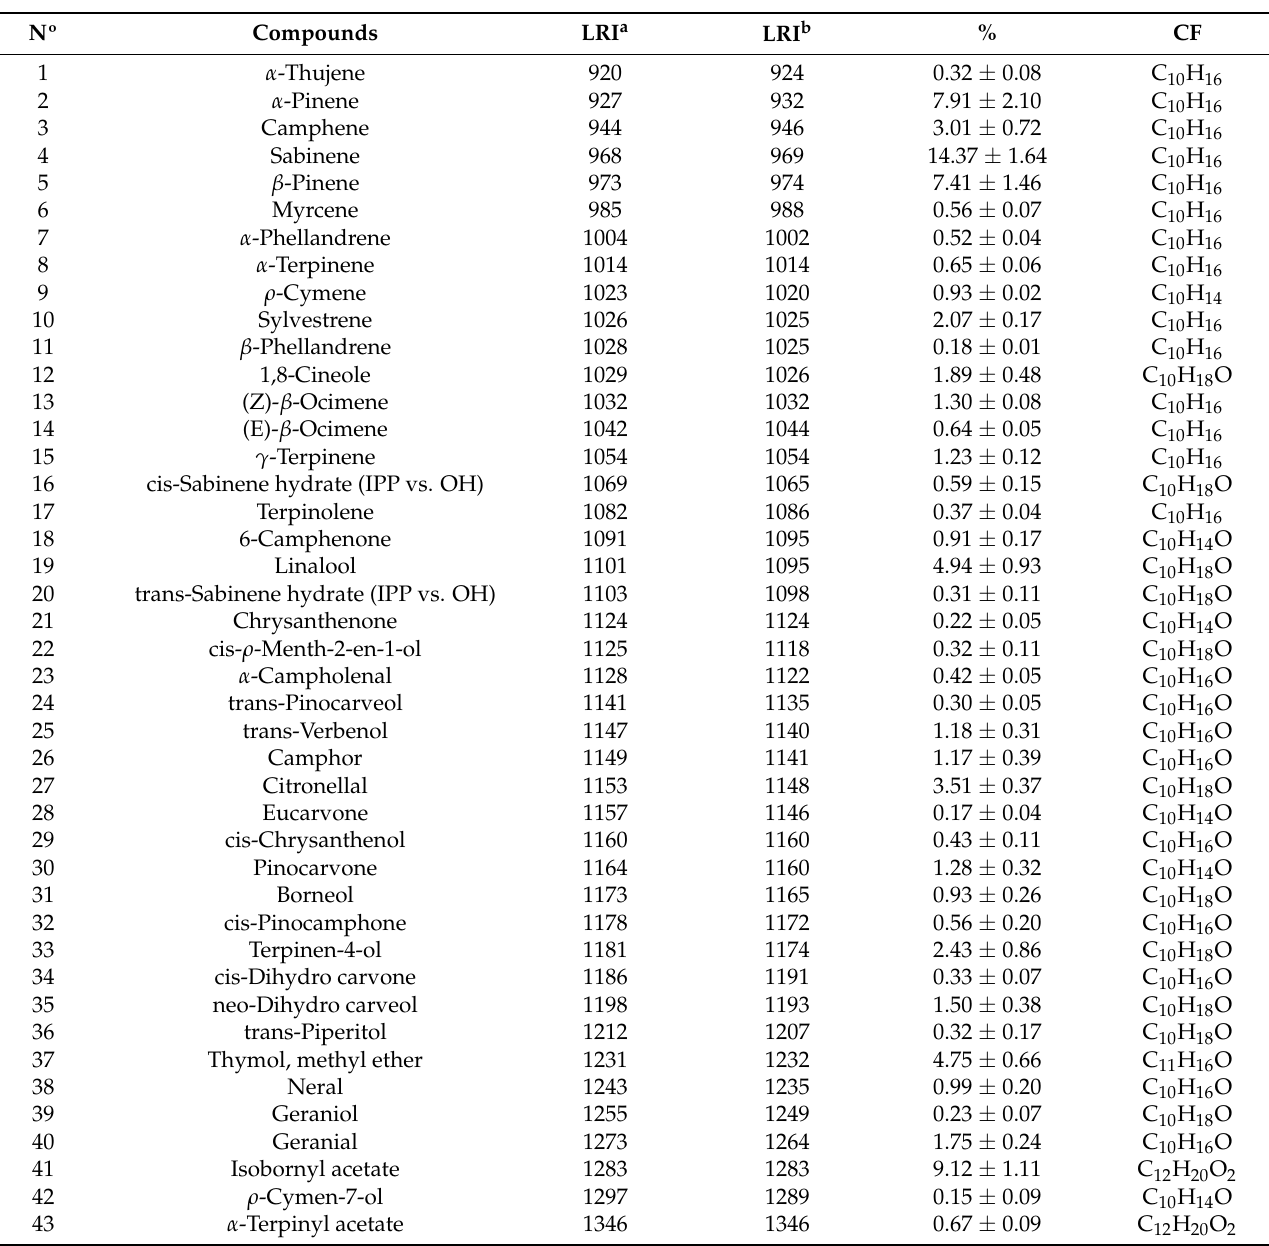
Table 1. Chemical compounds present in the essential oil of the leaves of H. cumbalense